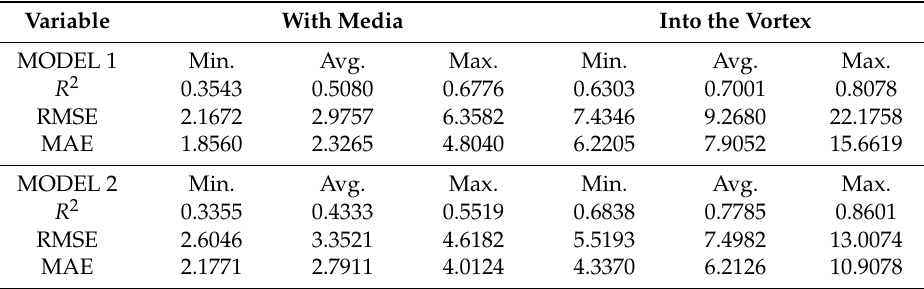
Table 9. Performance measurements of models one and two trained with the media feed and the feed into the vortex. Variable With Media Into the Vortex MODEL 1 Min. Avg. Max. Min. Avg.